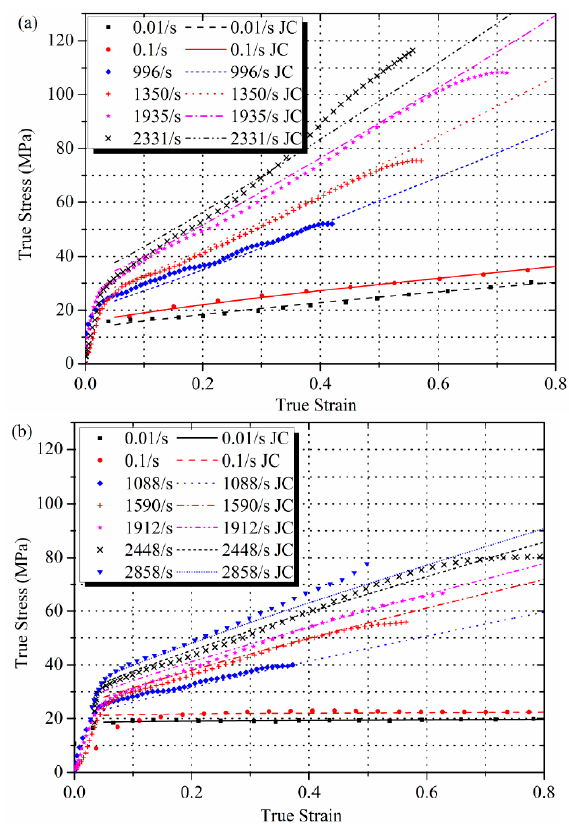
Figure 8. Comparison of Johnson-Cook model to ( a ) low crystalline and ( b ) high crystalline Al-PTFE experimental data.